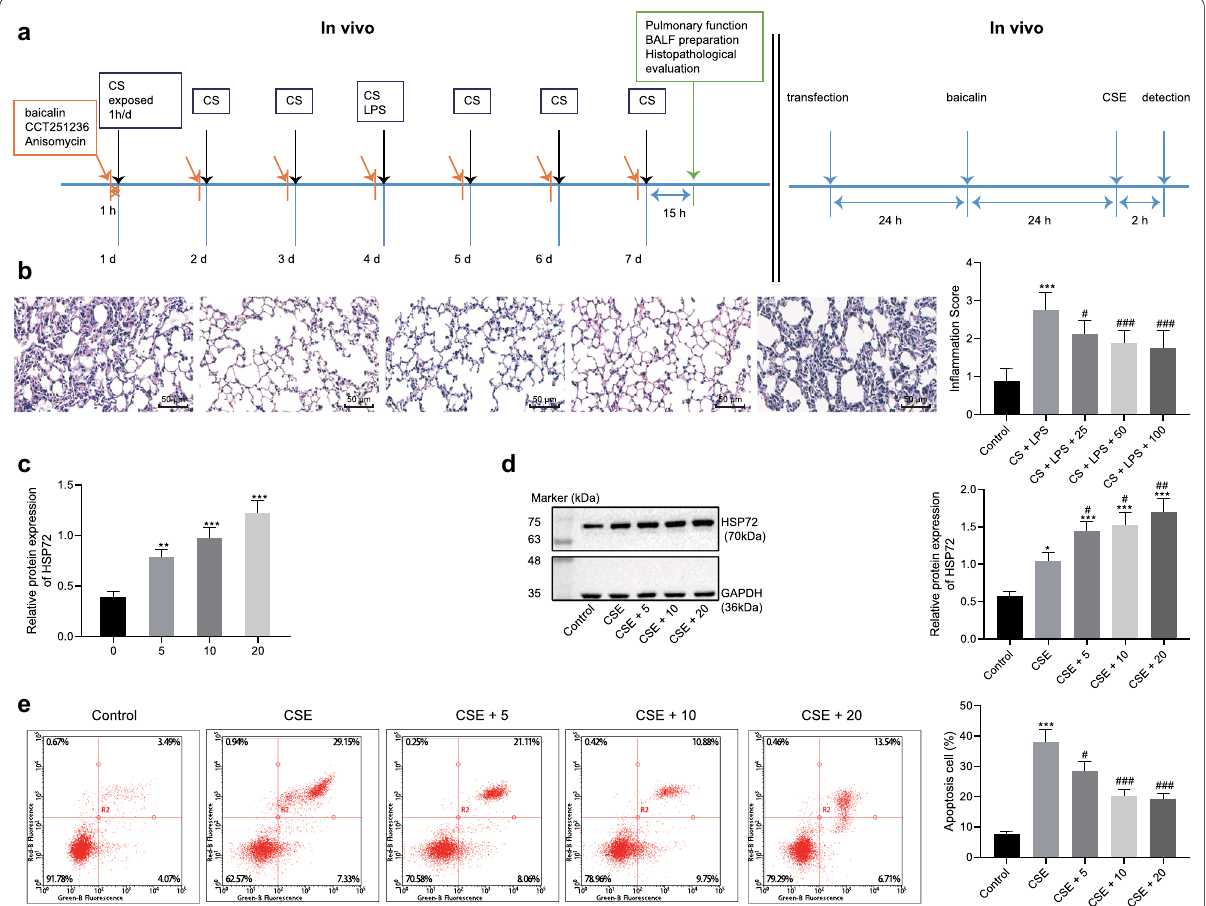
Fig. 1 Baicalin alleviates COPD and upregulates the expression of HSP72. COPD was induced by exposing the mice to CS and LPS. a Flow-process diagrams of in vivo and in vitro experiments. b Inflammatory cell infiltration in the lung was analyzed by H&E staining ( 200) and the severity of × inflammation was scored. c The expression of HSP72 in MLE-12 cells after baicalin treatment for 24 h, * p < 0.05 compared to mice treated with 0 µmol baicalin. d The expression of HSP72 normalized to GAPDH was analyzed using immunoblotting after MLE-12 cells were treated with baicalin for 24 h and stimulated by CSE for 2 h. e Cell apoptosis of MLE-12 cells were determined using flow cytometry. * p < 0.05, ** p < 0.01, *** p < 0.0001 compared to normal mice, # p < 0.05, ## p < 0.01, ### p < 0.001 compared to mice treated with CSE. All experiments were repeated three times independently and the data were represented as mean standard deviation. One-way ANOVA followed by Tukey’s test was used for multiple group ±